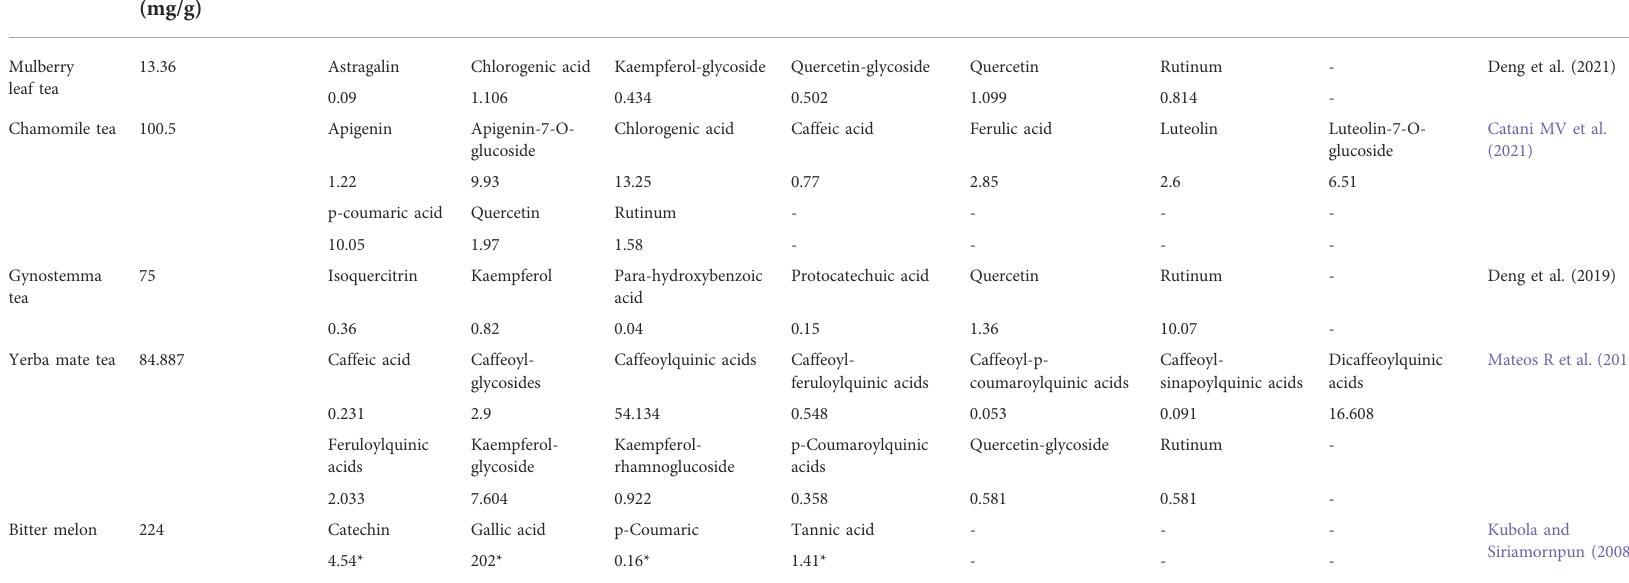
TABLE 4 Polyphenol content in